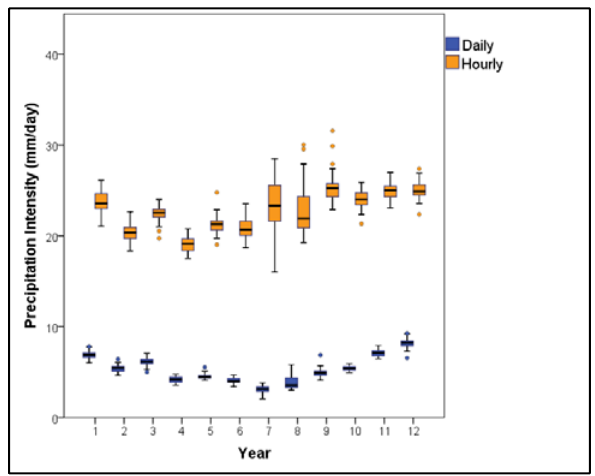
Figure 6. Daily and hourly precipitation intensities for all years and stations for March ( a ) and October ( b ). The box shows 50% of the data, with median represented as a black bar. The whisker extends to two standard deviations of the data, and circles represent outliers.